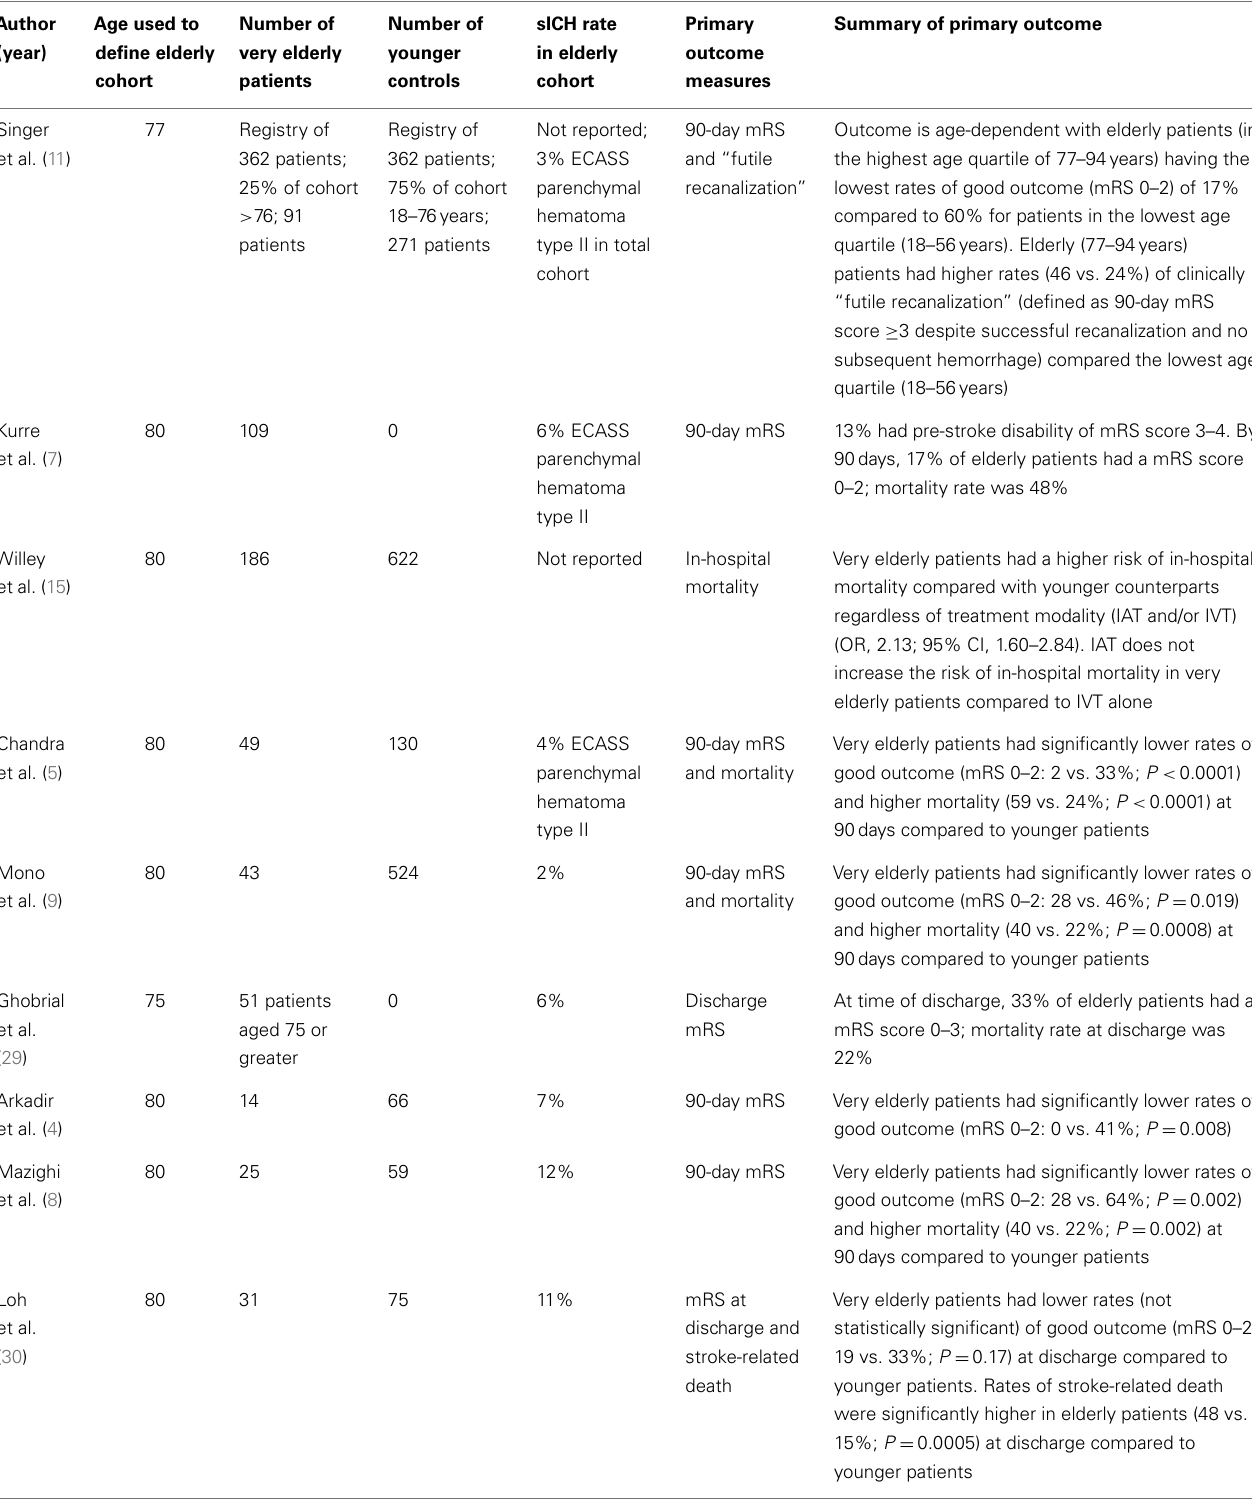
Table 1 | Summary of current published studies designed to assess clinical outcome after very elderly patients with anterior circulation stroke undergo IAT